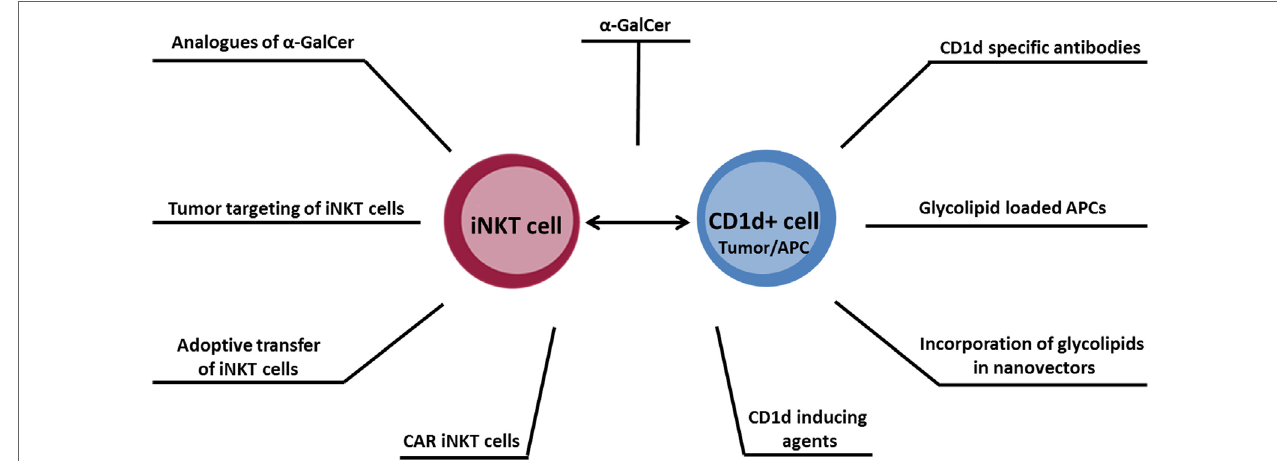
FiGURe 1 | Overview of antitumor therapeutic approaches designed to target the CD1d–invariant natural killer T cell